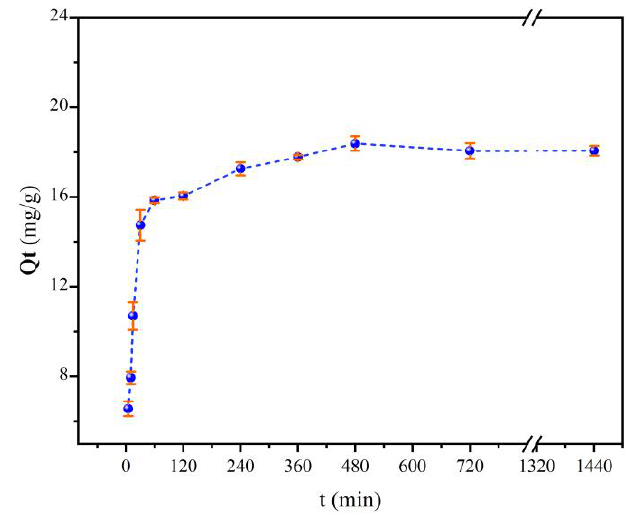
Figure 2. Sorption equilibration time of TC on sediments at 20 °C.